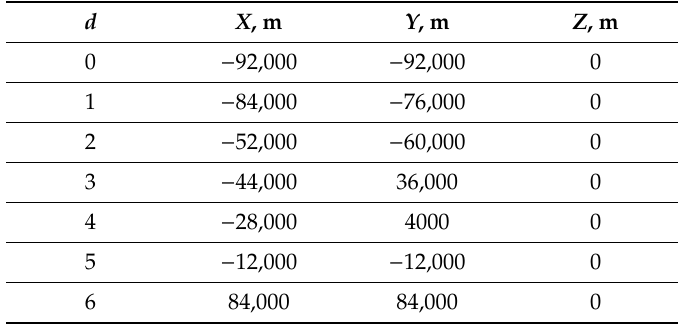
Table 2. True coordinates of the desired route